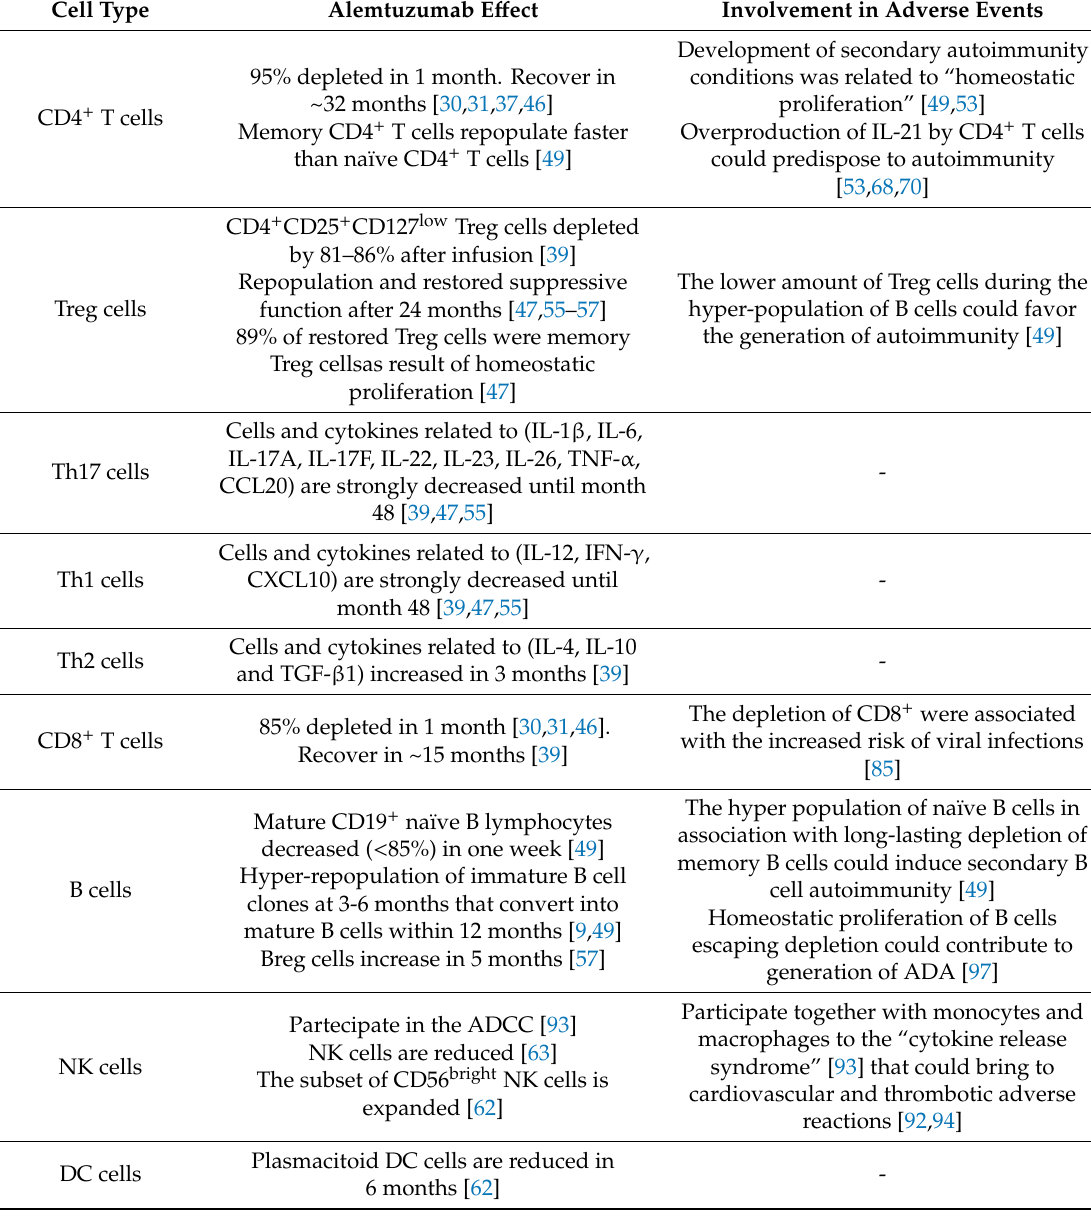
Table 1. E ff ects of alemtuzumab on di ff erent immune cell types and their correlation with immune reconstitution and the generation of adverse